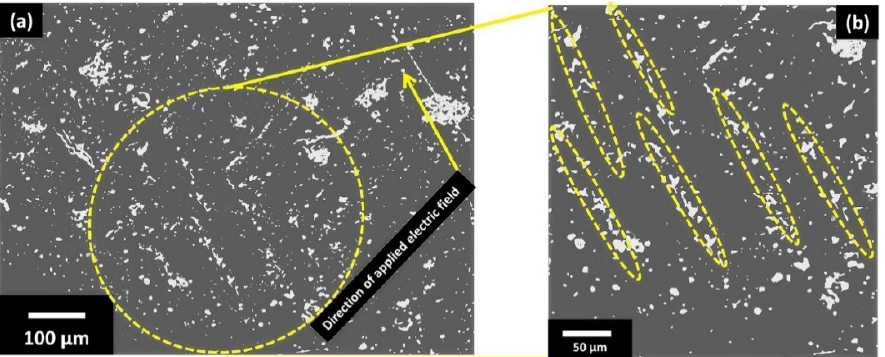
Figure 7. ( a ) Scanning electron microscope image of cross section of in-situ 3D printed and DEP functionalized PLA-10 vol% KNLN composite under 1 kV/mm at 210 °C; ( b ) magnified view.